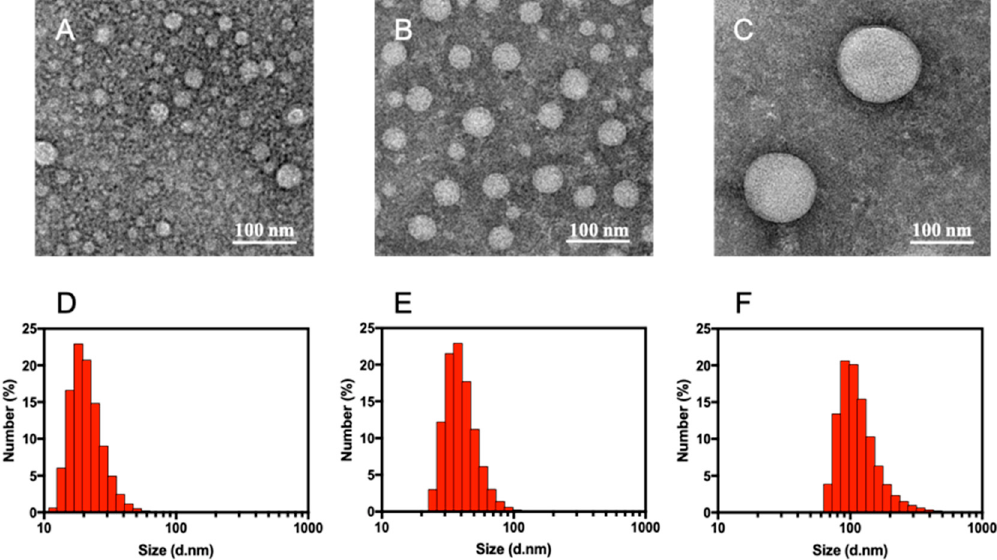
Figure 1. Transmission electron microscope (TEM) images ( A – C ) and hydrodynamic diameters determined with dynamic light scattering (DLS) of BSA NPs ( D – F ) at 20, 40, and 100 nm. The scale bar represents 100 nm.